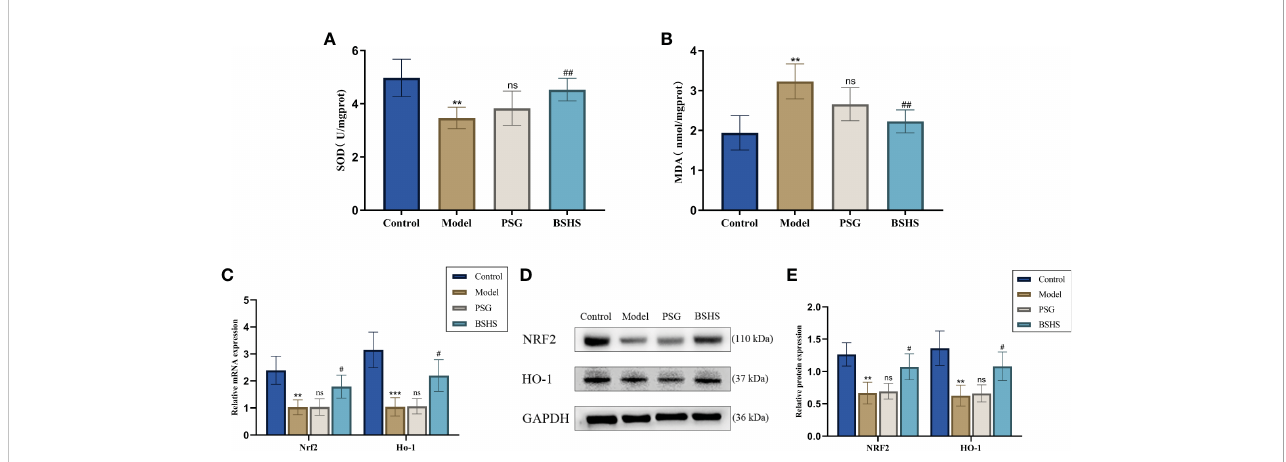
FIGURE 6 A comparison of oxidative stress levels in kidneys among different groups. (A) SOD activity in the kidneys of rats. (B) MDA content in the kidneys of rats. (C) qRT-PCR was used to evaluate the expression of genes related to oxidative stress. (D) The expression of oxidative stress-related proteins was evaluated by Western blotting. (E) A semi-quantitative analysis of NRF2 and HO-1 is shown. Data are presented as the mean ± SD and density normalized to GAPDH. ** p < 0.01 vs . the normal control group, *** p < 0.001 vs . the normal control group, # p < 0.05 vs . the model group, ## p < 0.01 vs . the model group, ns for p > 0.05 vs . the model group.